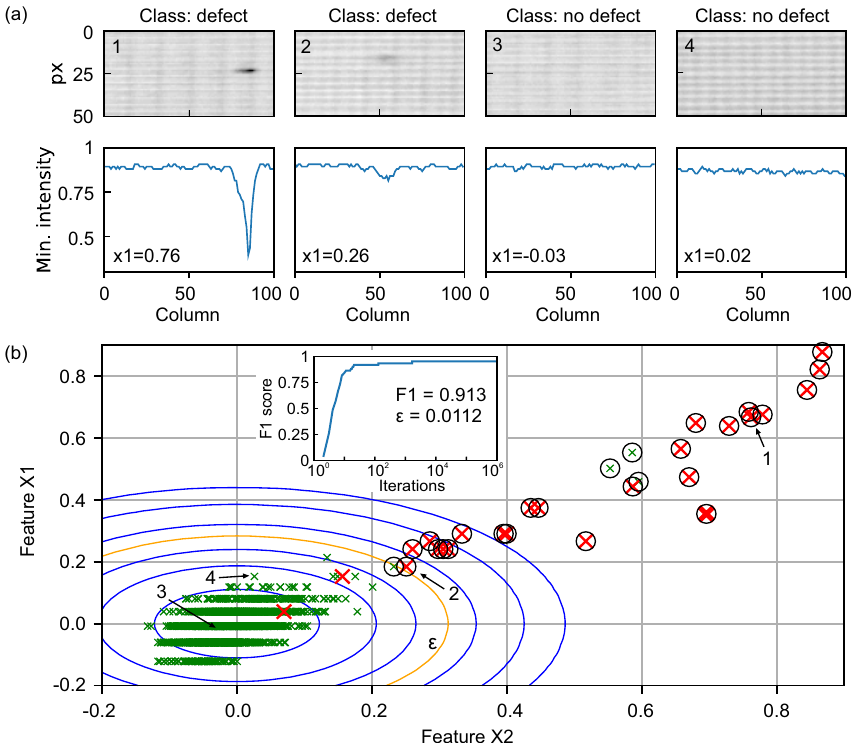
Figure 8. ( a ) Some examples for image segments manually labeled as positive (class: defect) or negative (class: no defect)). The plots below the images show the minimum intensity values per column, corresponding to significant values in feature X1 (standard deviation of minimum value), where true defects are present. ( b ) Two-dimensional feature space of the data set. Green (red) crosses represent samples manually labeled as positive (negative). Contour lines of the multivariate Gaussian probability distribution after training plotted at integer powers of 10 (outwards from +3 to − 3) times the decision boundary ε plotted as yellow line. The black circles mark the samples classified as outliers (defects) by the anomaly detection algorithm. The inset shows the good F1 score of 0.913 reached at around 3000 iterations of